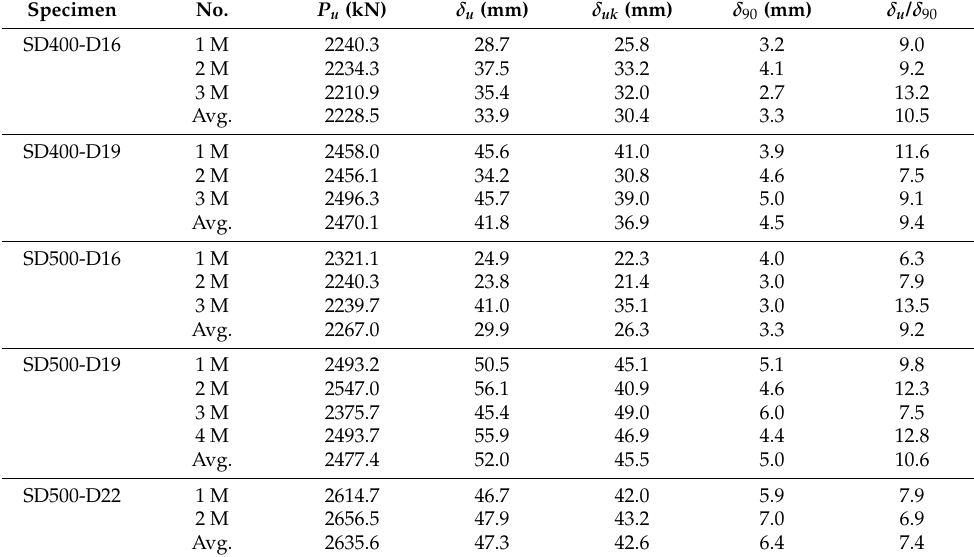
Table 5. Test results of shear resistance and ductility.